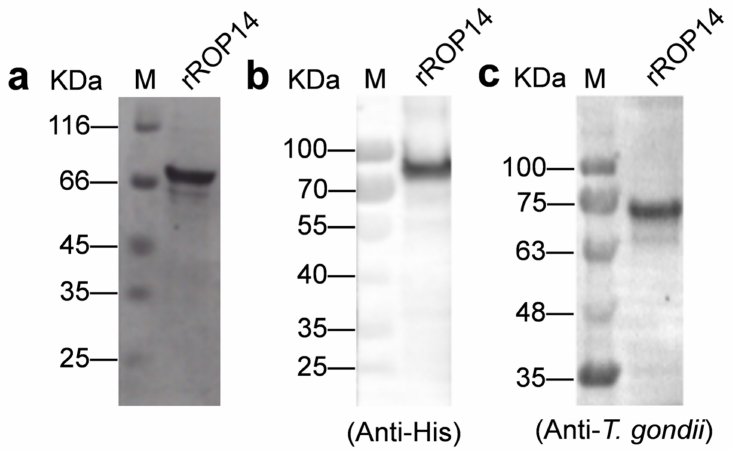
Figure 2. Analysis of the recombinant protein rTgROP14-His by SDS-PAGE ( a ) and Western blot ( b , c ). M: protein marker, rROP14: rTgROP14-His. The primary antibodies in panels b and c are anti-His antibody and polyclonal mouse antibodies to T. gondii ,